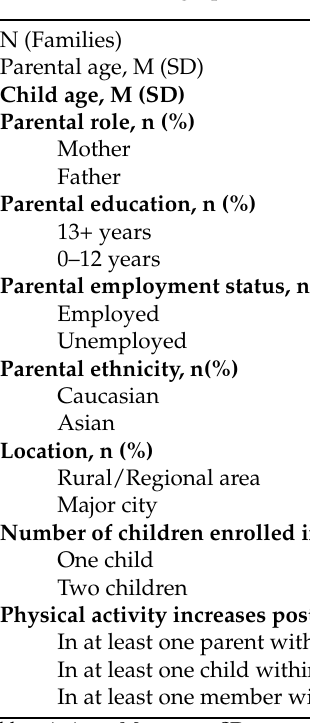
Table 1. Sociodemographic characteristics of